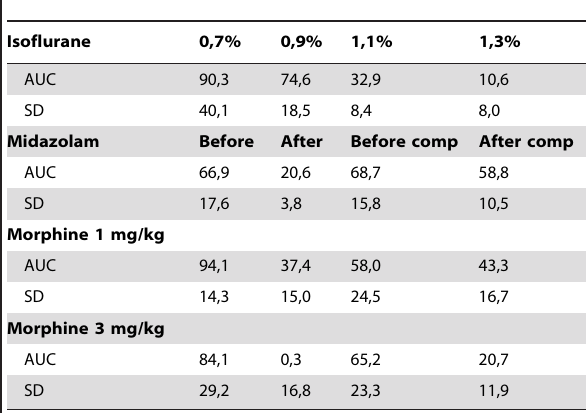
Table 2. LCEP area under curve (AUC) mean values before normalization (see methods) and corresponding standard deviation (SD) from the different set of